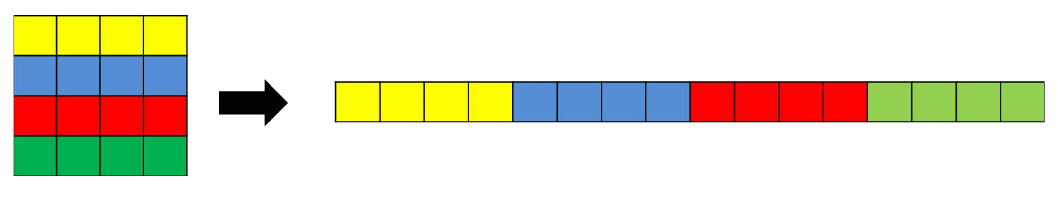
Figure 13. Matrix vectorization: All rows from a two-dimensional matrix are put sequentially into a linear